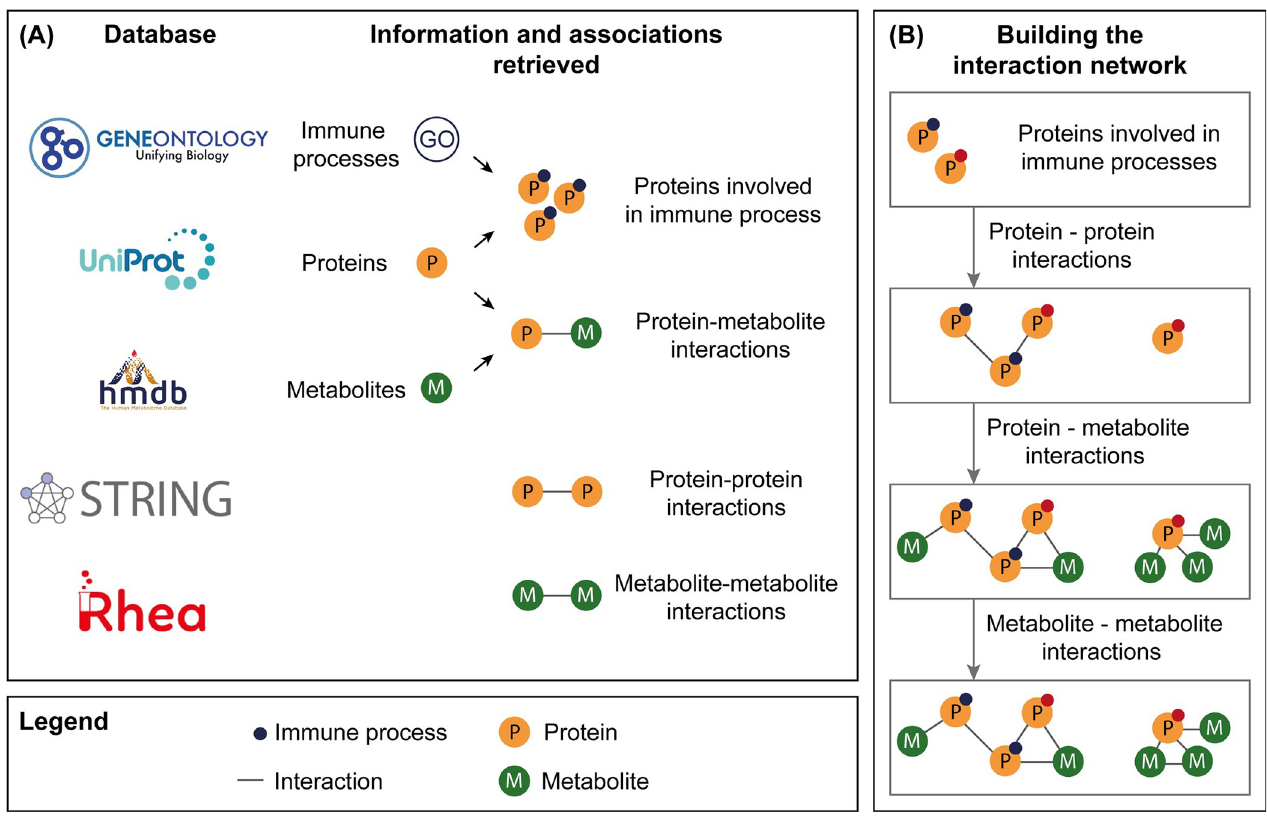
Fig 2. Overview of (A) information and associations retrieved from available databases, and (B) the study flow to build protein-metabolite interaction networks to associate metabolites and immune processes of interest. First, the proteins that are associated with the immune processes of interest are added to the network. Then, protein-protein, protein-metabolite, and metabolite-metabolite interactions are added to the network to generate the final interaction network for the immune processes of